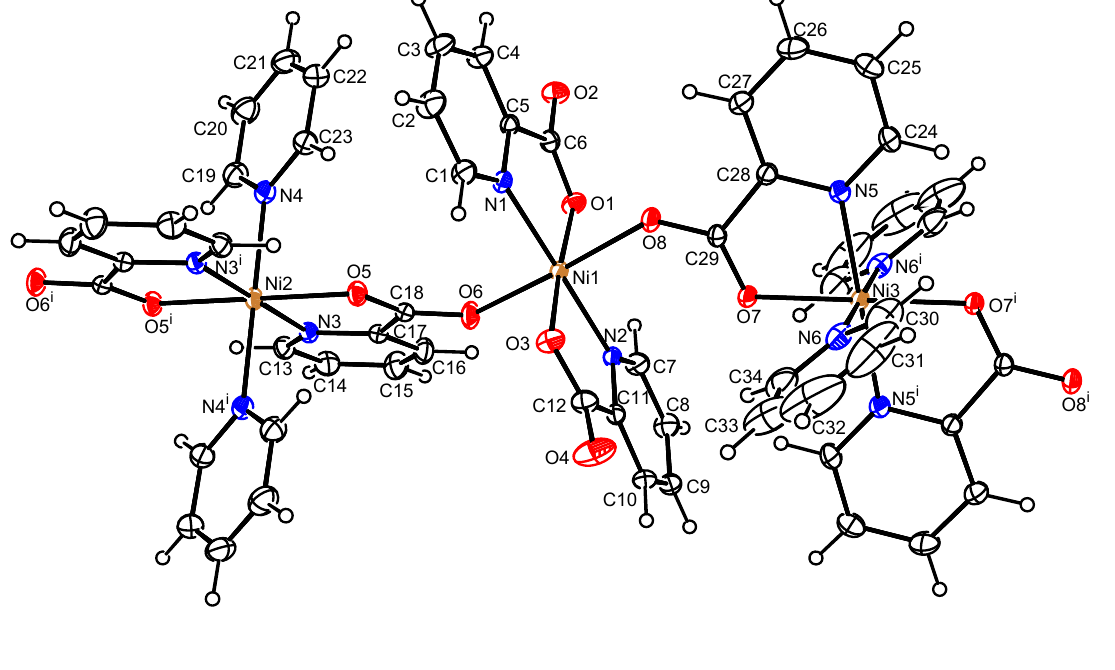
Table  : Data collection and